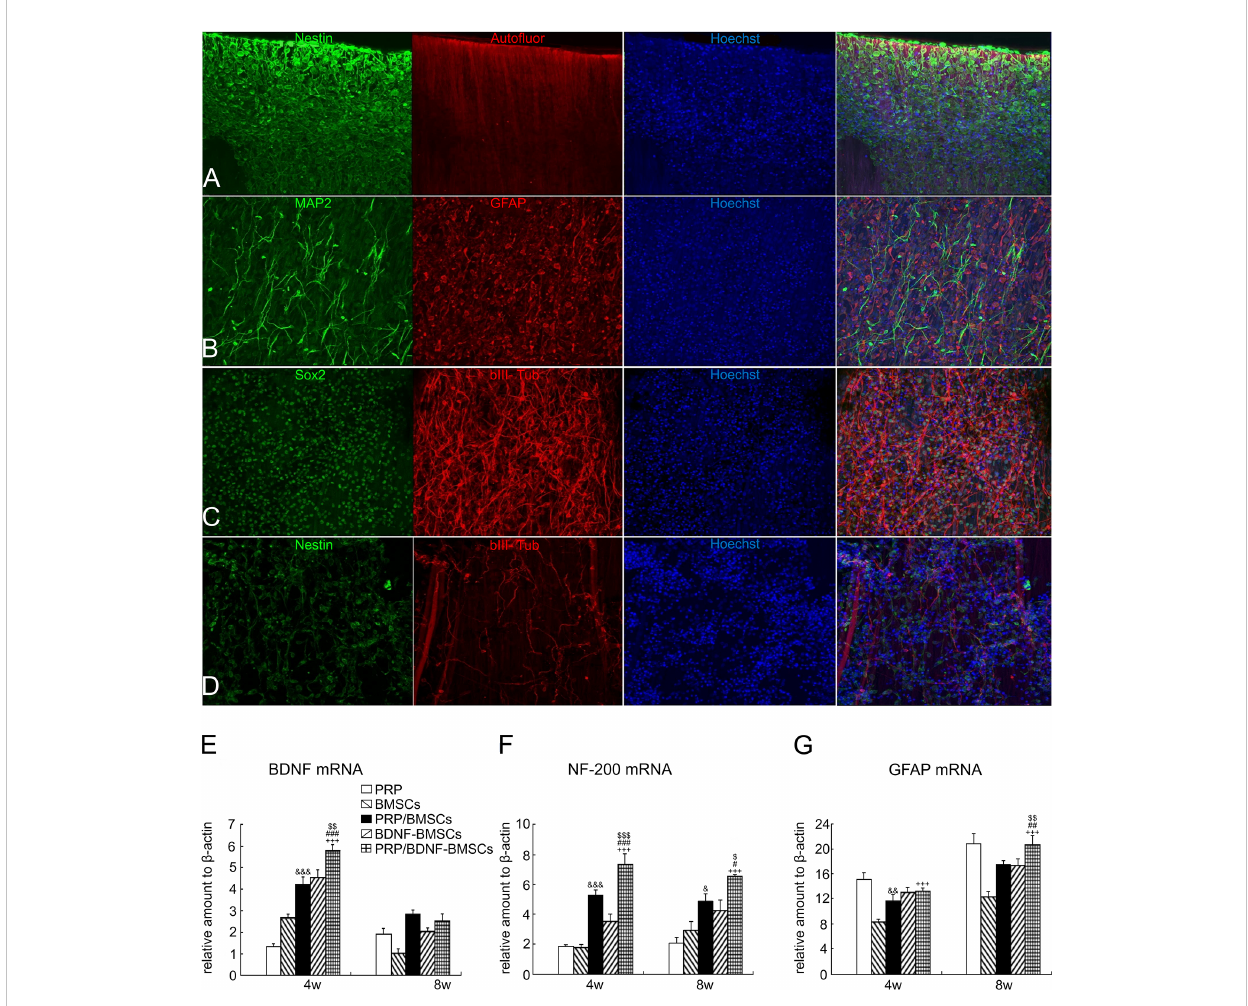
FIGURE 3 PRP treatment of spinal cord injury. (A-C) drNPC cultured on the two component SPRPix matrix (PRP hydrogel embedded into the rSS-PCL scaffold) demonstrated a high level of adhesion and neuronal differentiation: drNPC completely covered the entire SPRPix matrix surface and formed long b III-tubulin- and MAP2- positive processes oriented along the spidroin micro fi brils. (D) No directional growth was observed in scaffolds without PRP. (E – G) The expression of BDNF, NF-200 and GFAP genes was signi fi cantly increased after PRP and BMSCs were used together. Reproduced with permission from (77, 78). $ or $$ or $$$ P< 0.05 or P< 0.01 or P< 0.001 (PRP/BDNF-BMSCs vs. BDNF-BMSCs), # or ## or ### P< 0.05 or P< 0.01 or P< 0.001 (PRP/BDNF-BMSCs vs. PRP/BMSCs), +++ P < 0.001 (PRP/BDNF-BMSCs vs. BMSCs alone),& or && or &&&P < 0.05 or P < 0.01 or P < 0.001 (PRP/ BMSCs vs. BMSCs